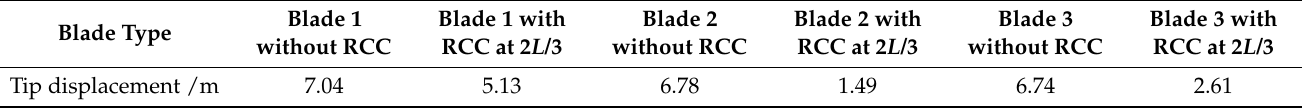
Table 4. Tip displacement response of blades.